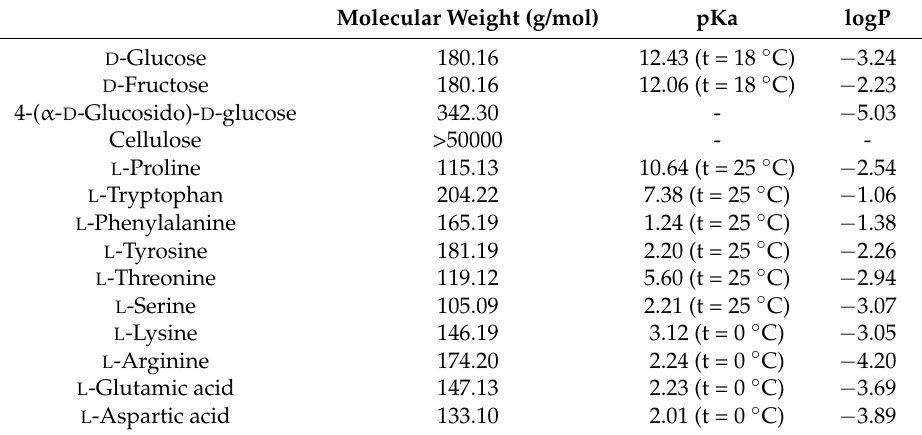
Table 4. Molecular weight, pKa and logP of each study